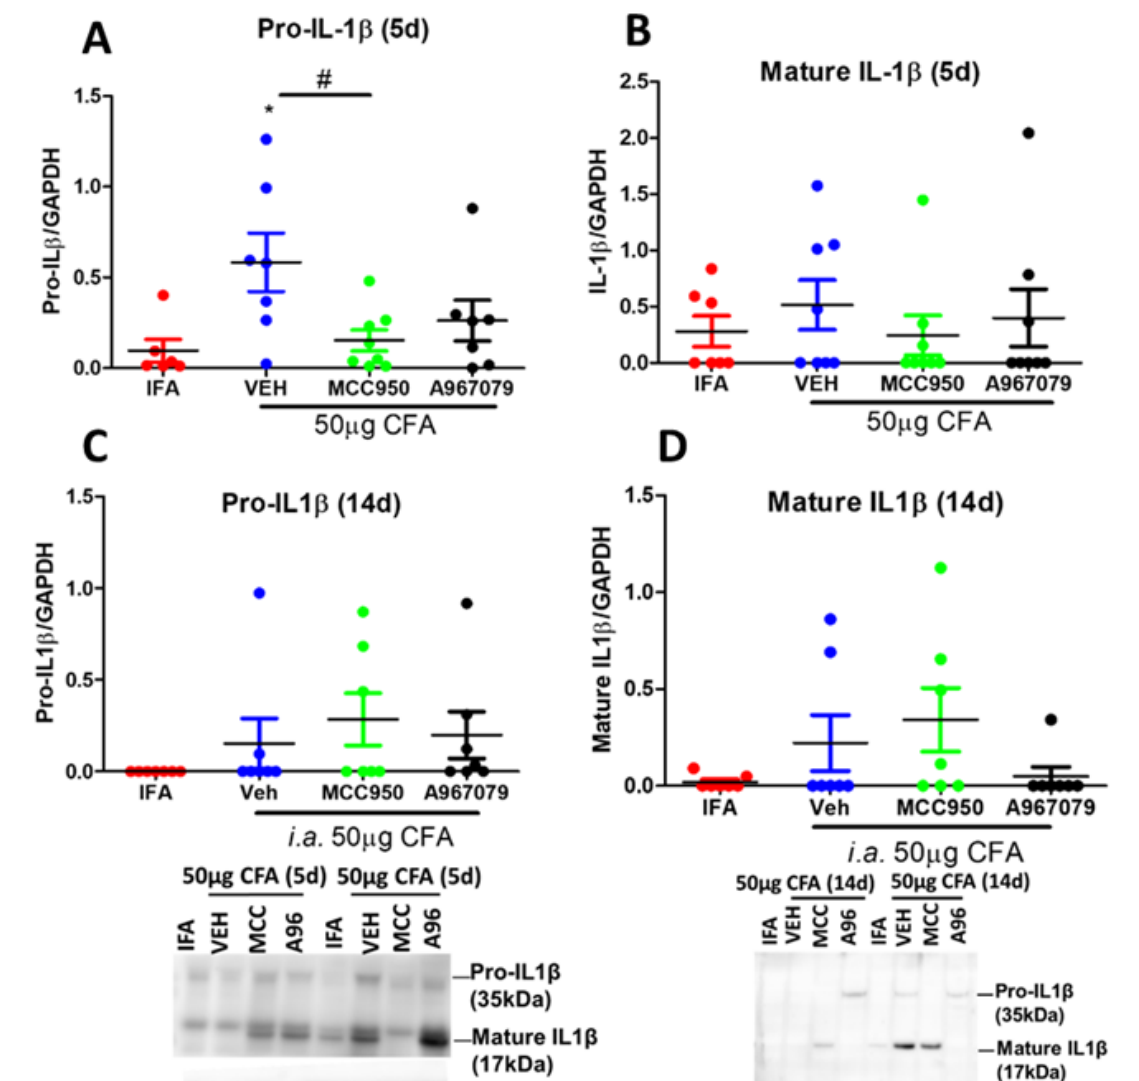
Figure 5. Western blotting for inflammasome-related markers in CFA-injected TMJs collected at days 5 or 14 in response to repeated treatments with a TRPA1 antagonist (A967079) or an NLRP3 antagonist (MCC950). ( A , C ) ProIL-1 β in TMJs collected at days 5 or 14; ( B , D ) Mature IL-1 β in TMJs collected at days 5 or 14. Below are the representative blot images. Data represent mean ± SEM, n = 7 − 8 animals per group. Data analysed by one-way repeated measures ANOVA with Bonferroni’s post hoc test. * p < 0.05 IFA vs. CFA, # p < 0.05CFA/VEH vs. CFA/MCC950.